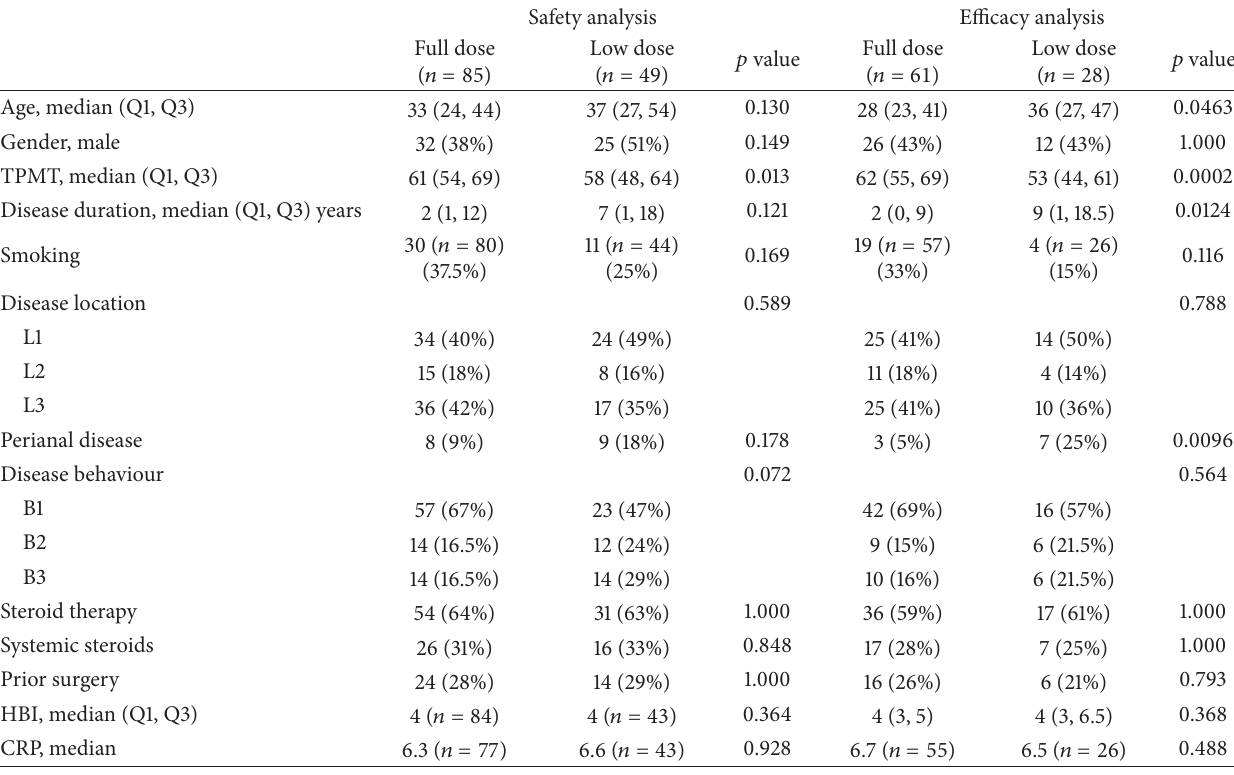
Table 1: Baseline characteristics of all patients before and after exclusion due to missing HBI.